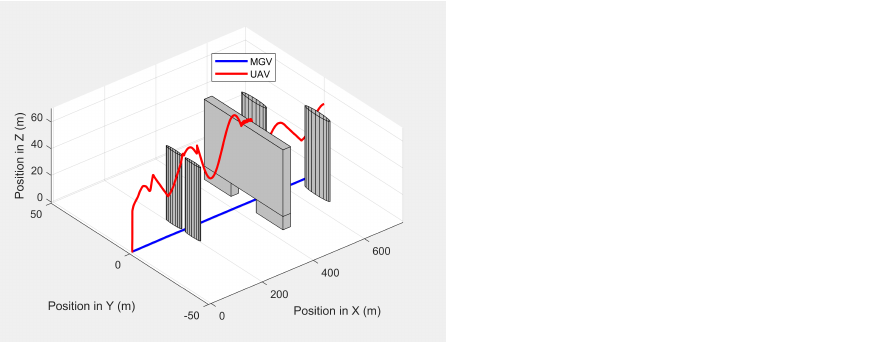
Figure 19. The UAV’s planned path in 3D when following the MGV in the presence of static